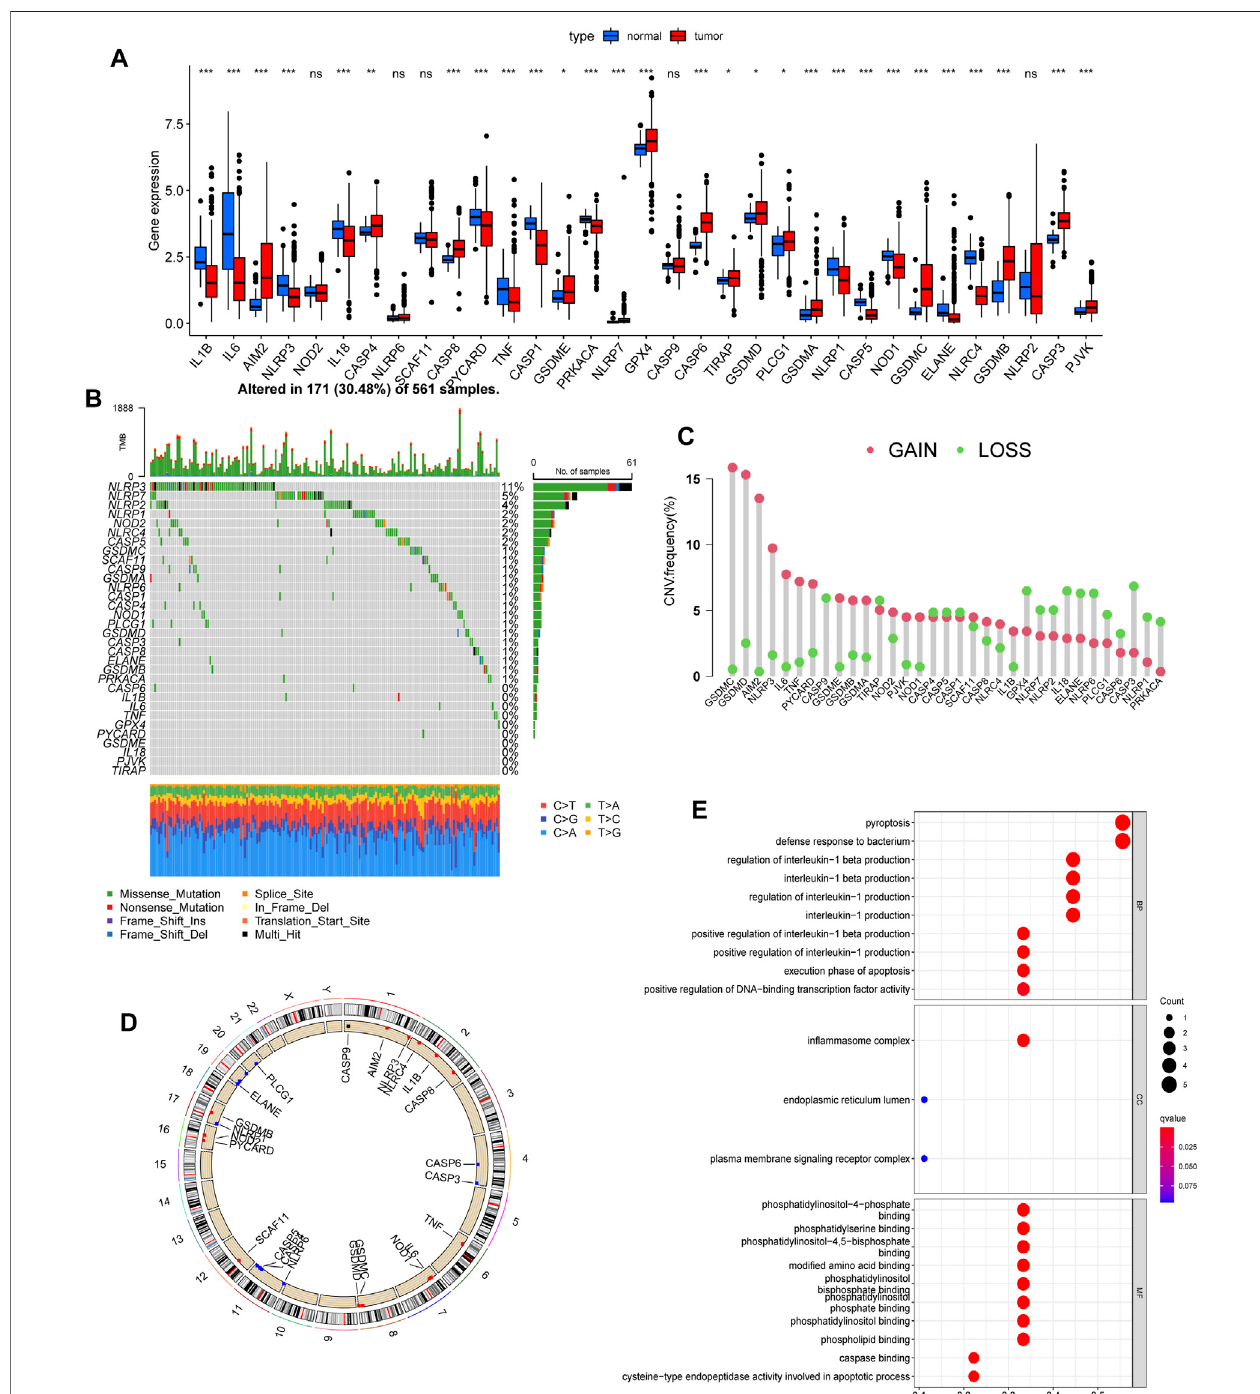
FIGURE 1 | Landscape of expression, genetic variation, and functional enrichment of pyroptosis-related genes in LUAD. (A) Expression of pyroptosis-related genesbetweennormaltissuesand LUAD tissues (Wilcoxon test, * p < 0.05;** p < 0.01; *** p < 0.001;ns, notstatisticallysigni fi cant). (B) Landscape ofmutationpro fi les in LUAD patients from the TCGA cohort. (C) CNV frequency of 33 pyroptosis-related genes. (D) Location of CNV alternation of pyroptosis-related genes in the chromosome. The red dots represent more samples with increased copy number gains than samples with copy number losses, while the blue dots are the opposite. The black dot means the two are equal. (E) Enrichment analysis of GO biological process, cellular component, and molecular function. LUAD, lung adenocarcinoma; CNV, copy number variation.